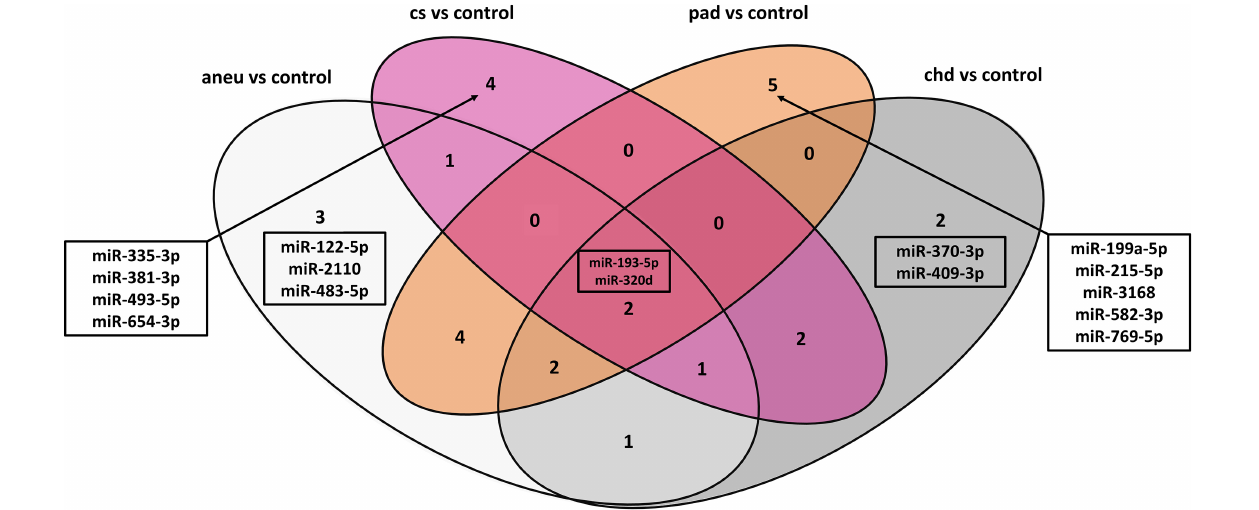
found in both analyses for the cs group. miR-122-5p and miR- 483-5p were found for the aneu group, miR-3168, miR-583-3p,